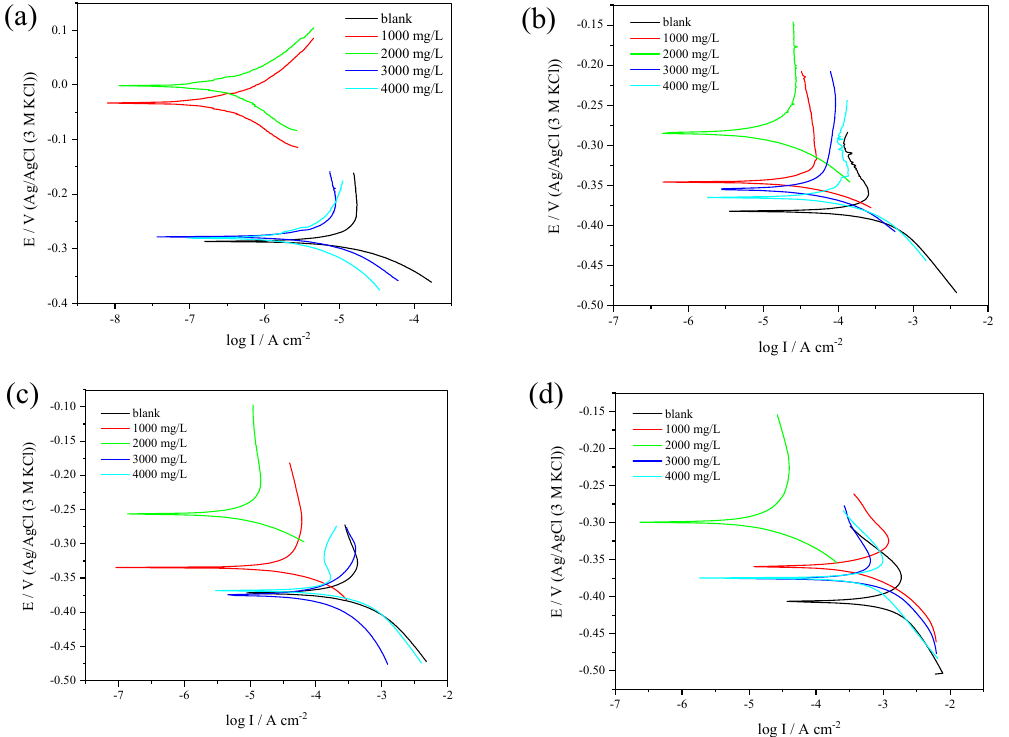
Figure 4. Tafel plots for 304 SS with and without inhibitor in 0.5 M ( a ), 1.0 M ( b ), 1.5 M ( c ), and 2.0 M H 2 SO 4 solution ( d ).